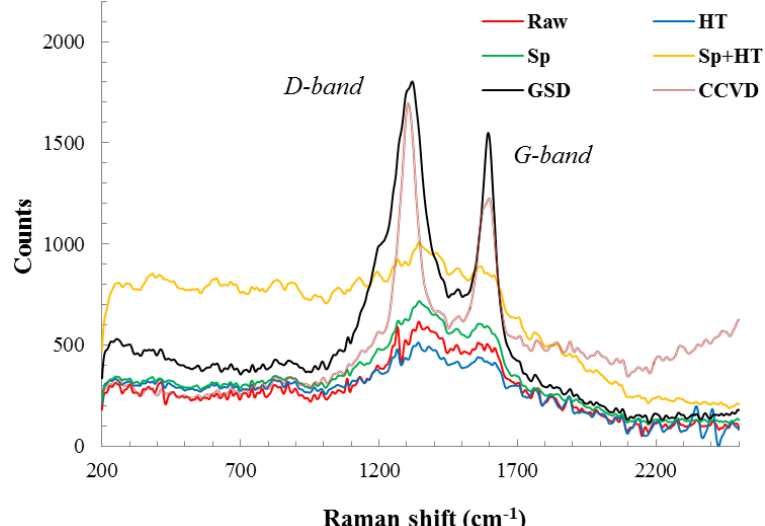
Figure 4. Raman spectra of the surfaces of different processed carbon fibers. Specimens are based on raw polyacrylonitrile (PAN)-based carbon fabric (Raw), SiO fabric (Sp), heat-treated fabric (HT), SiO (Sp + HT), and with CNTs grown on their surfaces via graphitic structures by design (GSD) and catalytic chemical vapor deposition